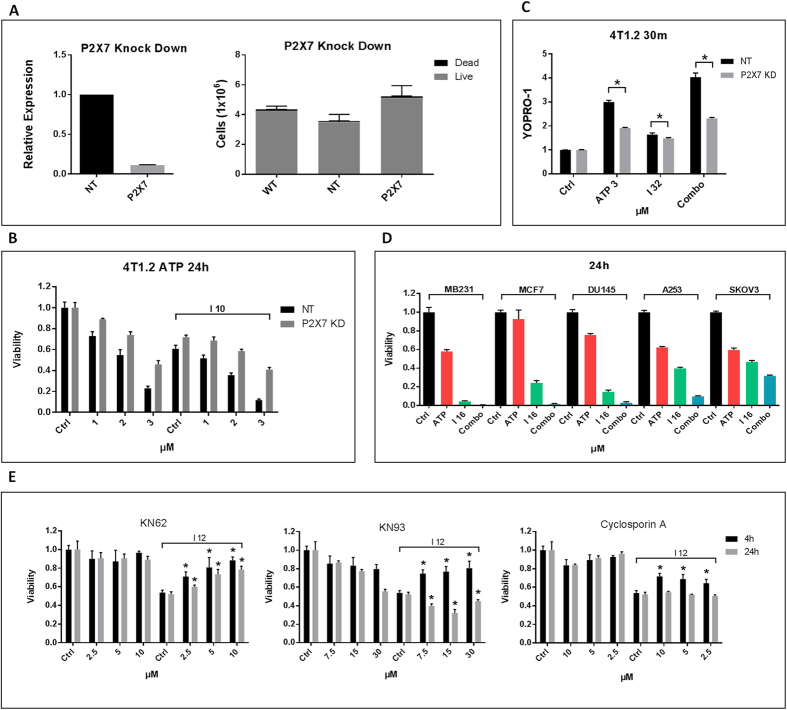
CaMKII-independent P2X7-mediated killing.(A) qPCR showing the extent of gene knockdown in 4T1.2 cells transfected with shRNA targeting the P2X7 receptor versus non-targeting (NT) control (left panel). The right panel shows that P2X7 knockdown does not compromise cancer cell growth and viability. One million wt, shRNA(NT) and shRNA(P2X7) 4T1.2 cells were plated and incubated for 48h before evaluation of cell numbers and viability. (B) P2X7 knockdown cells are more resistant to ATP and the ATP/IVM combo. 4T1.2 cells were treated for 24 h with 1–3 mM ATP, 6–10 μM Ivermectin, or combinations of ATP and Ivermectin. P2X7 knockdown suppresses the synergy between Ivermectin and high dose ATP, as shown by calculation of combination index (CI) values, see Table 2. (C) P2X7 knockdown cells are resistant to ATP/Ivermectin induced membrane permeabilization (Asterisk (*) indicates p < 0.05). (D) The combination of Ivermectin (16 μM) and exogenous ATP (3 mM) can synergistically kill even some resistant human cancer cell lines like breast (MCF7), prostate (DU-145), head and neck (A253), and ovarian (SKOV3) cancer cells. (E) Comparison of the protective effects of P2X7, CaMKII, and NADPH oxidases inhibition in short-term (4 h, 32 μM IVM) and long-term (24 h, 12 μM IVM) exposure of 4T1.2 cells to Ivermectin. Asterisk (*) indicates p < 0.05 relative to Ivermectin alone controls.